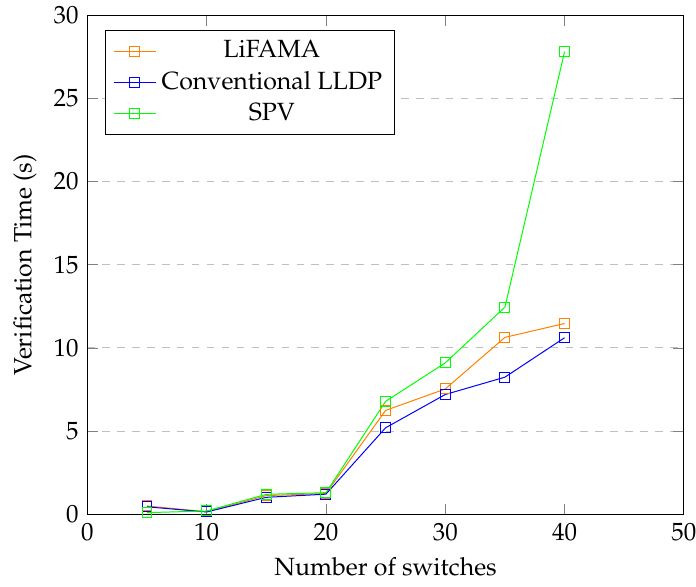
Figure 14. Fat tree topology